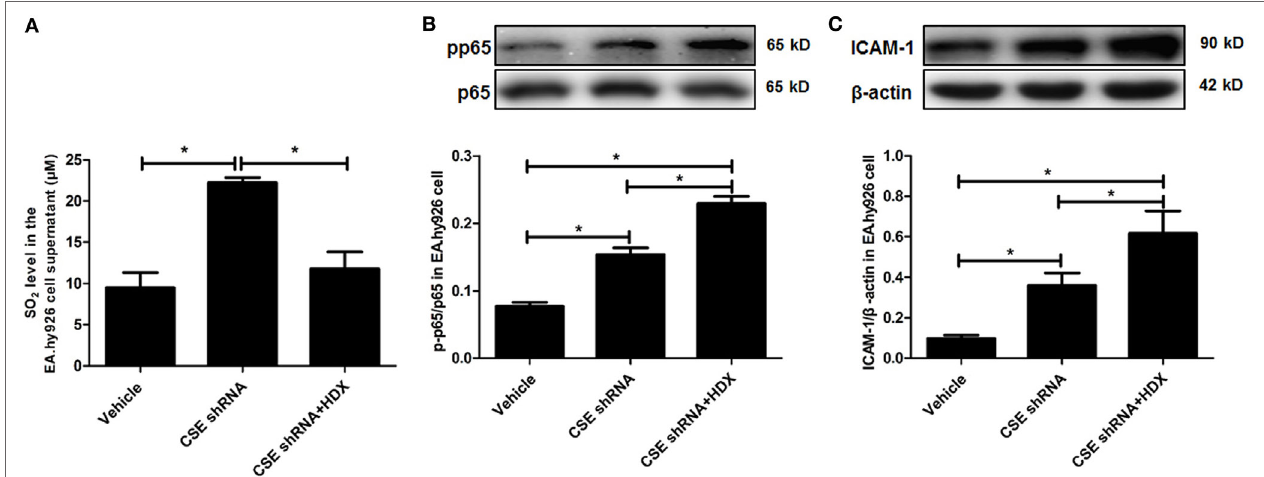
FigUre 5 | Aspartate aminotransferase inhibitor l -aspartate- β -hydroxamate (HDX) aggravated the inflammation caused by cystathionine- γ -lyase CSE knockdown in EA.hy926 cell. (a) The SO 2 level in the supernatant of EA.hy926 cells detected by HPLC analysis. (B) The phosphorylation of NF- κ B p65 in the EA.hy926 cell detected by western blot. (c) The expression of ICAM-1 in the EA.hy926 cell detected by western blot. * P < 0.05. Data are expressed as means ± SEM, and all experiments were performed independently for at least three times.